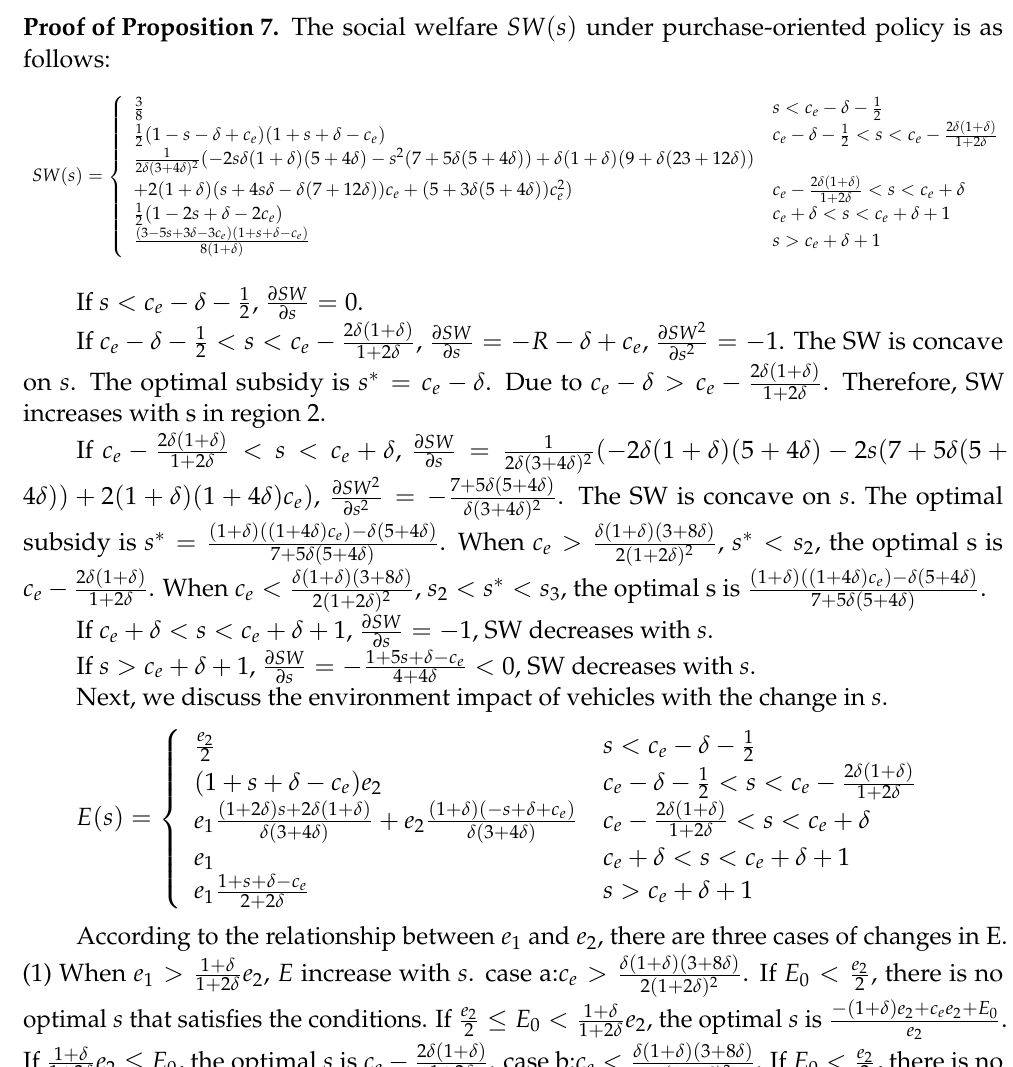
Figure A4. Changes in environmental impact under demand subisdy